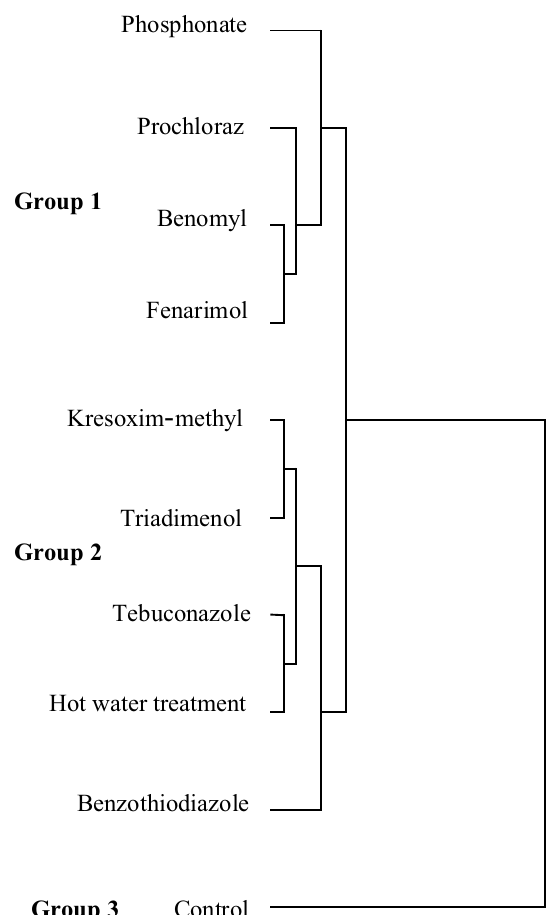
Fig. 1. Dendrogram of treatments with respect to their effectiveness against Phaeomoniella chlamydospora in- fection of one-year-old Pinot Noir rootlings constructed using cluster analysis determined by the group average method and Euclidean